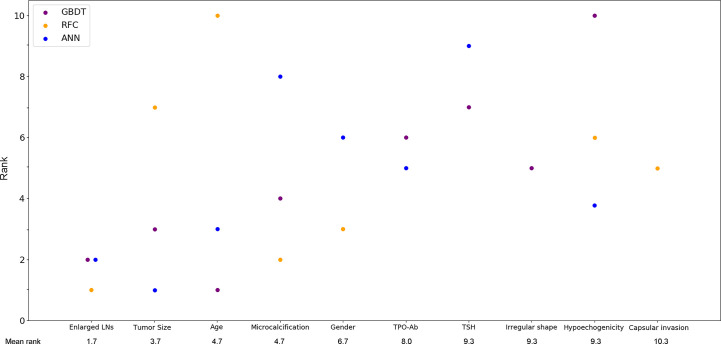
Ranks of the top 10 variables for the prediction of central lymph node metastasis. Variables were ranked using a classifier-specific importance evaluator based on machine learning algorithms. The variables are ordered according to the mean ranking of three potential models, which were GBDT, RFC and ANN. A lower rank represents more predictive importance. For example, age was ranked 1st, 3rd, and 10th in GBDT, ANN, and RFC, respectively. LNs, lymph nodes; Micro-Cal, microcalcification; TPO-Ab, thyroid peroxidase antibody; TSH, thyroid stimulating hormone; Ir. shape, irregular shape; Cap. invasion, capsular invasion; Hypo-echo, hypoechogenicity; GBDT, gradient boosting decision tree; RFC, random forest classifier; ANN, artificial neural network.